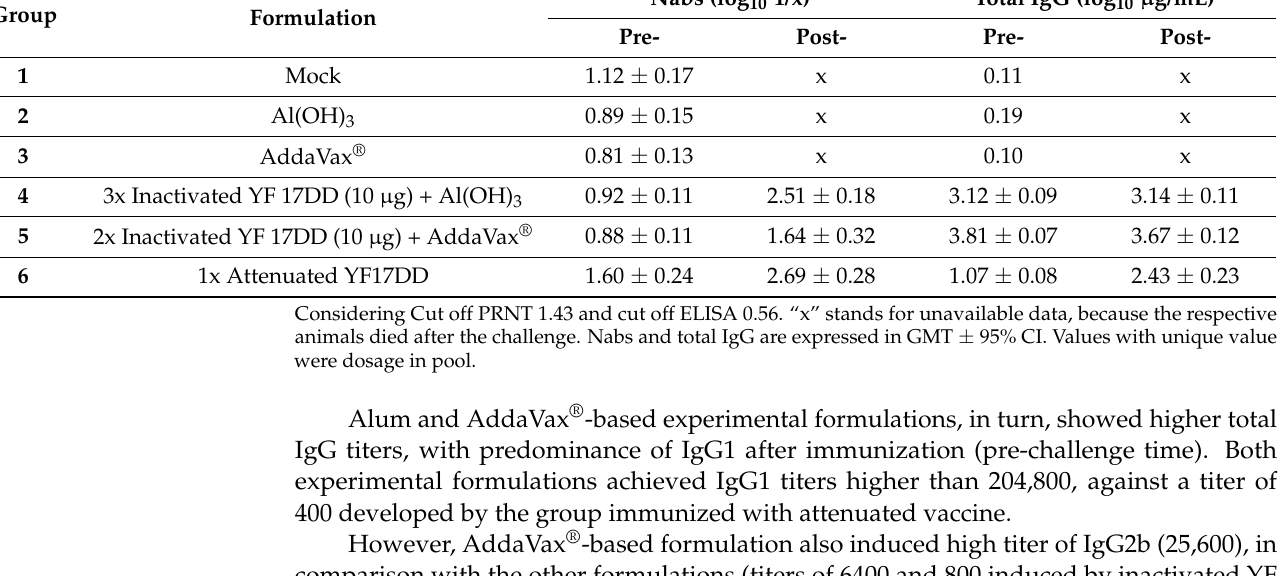
Table 2. Immunogenicity of the different formulations of inactivated YF 17DD in mice.